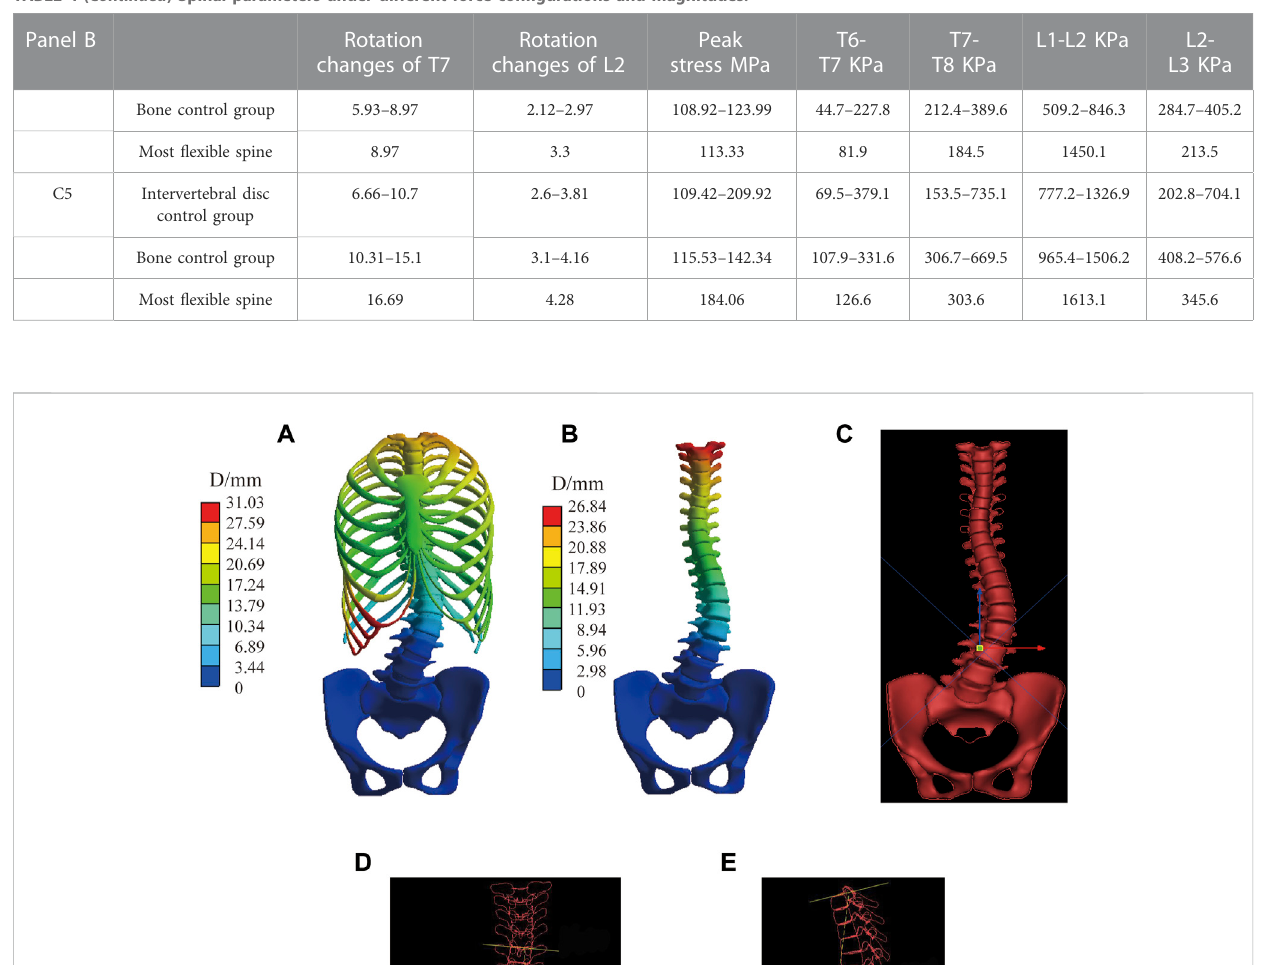
C2, and C3. While under C4 and C5, it occurred at the T5 and fi fth rib on the concave side of cruve. Stress mainly distribute in the ribs and the posterior border of vertebral body. In addition, a decrease in the elastic modulus of the intervertebral disc leads to an increase in the overall model stress; however, the opposite occurs for the bone (Table 4).